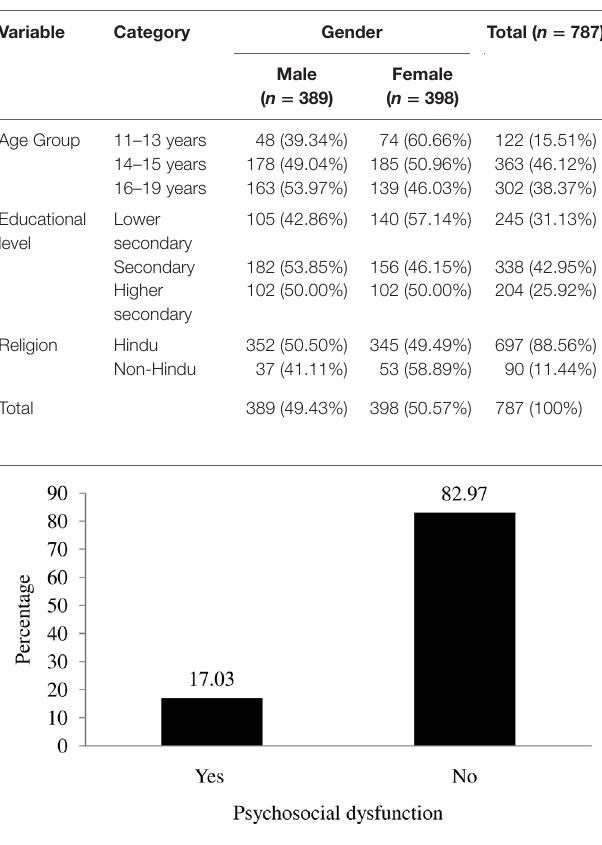
FigUre 2 | Prevalence of psychosocial dysfunction among adolescent students .